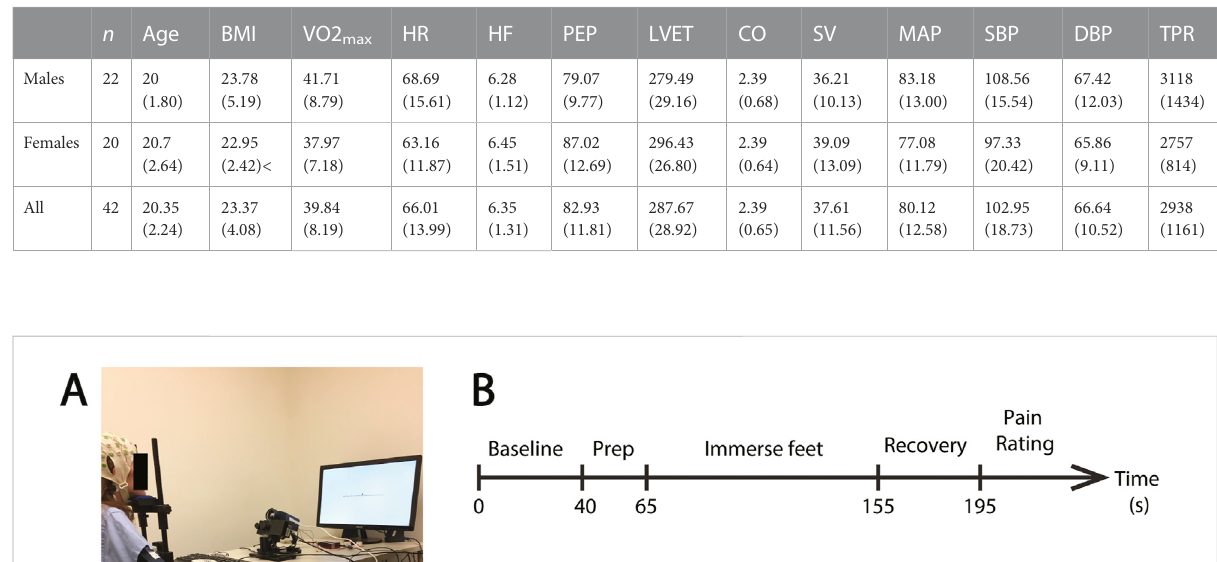
TABLE1Participantdemographicandbaselinecardiovasculardata,computedfromthemeanofthe fi nal15 softhebaseline periodin fi rsttrialofthecontrol condition. Mean (SD).